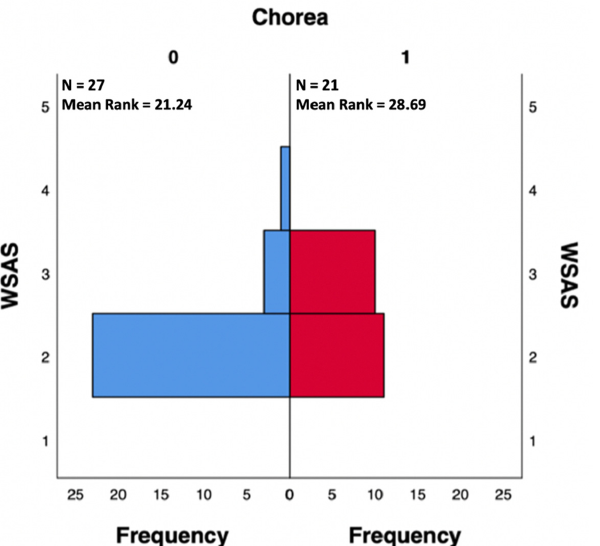
Figure 1. Independent-Samples Mann-Whitney U Test reporting significantly different WSAS scores between SC (Chorea 1) and nSC (Chorea 0) patients. between SC (Chorea 1) and nSC (Chorea 0) patients.